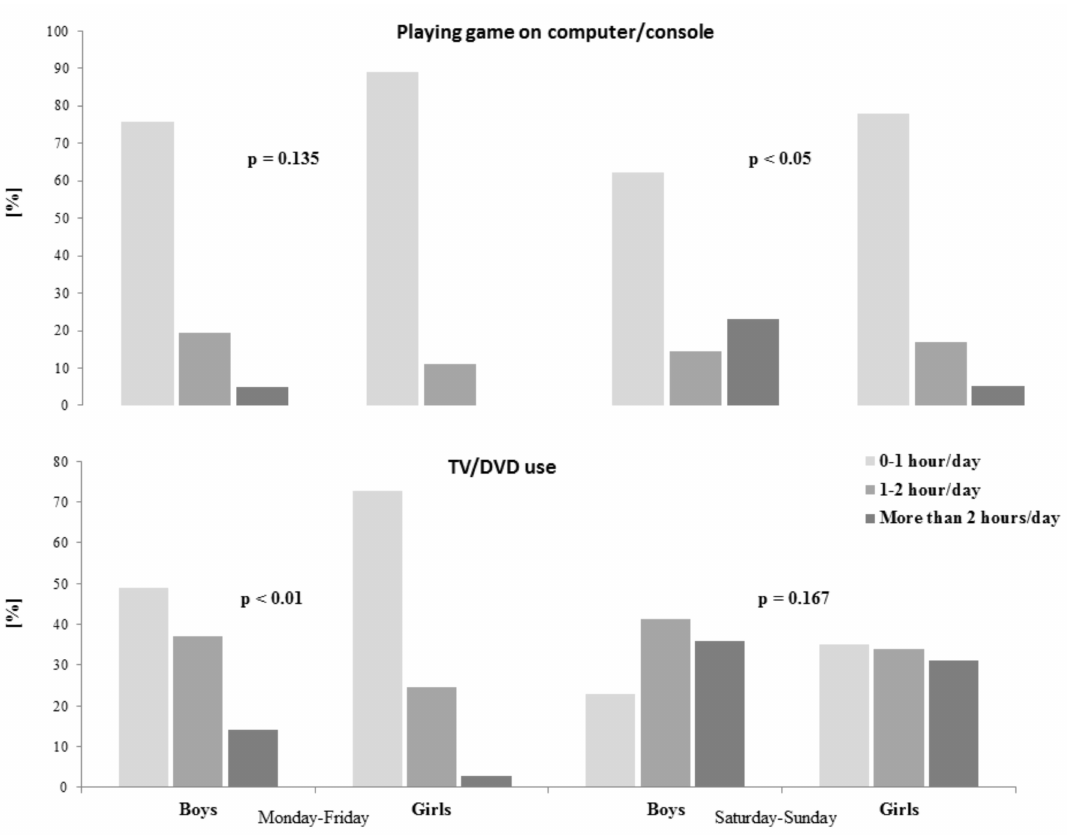
Figure 3. Di ff erences between boys and girls in time spent on sedentary